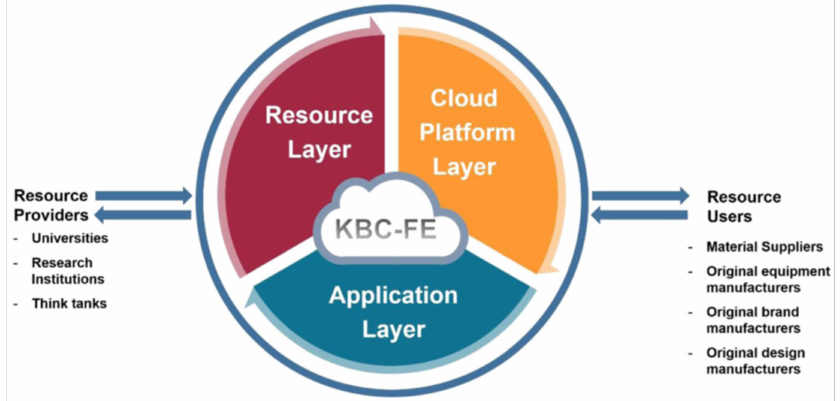
Figure 11. The frame work of KBC-FE